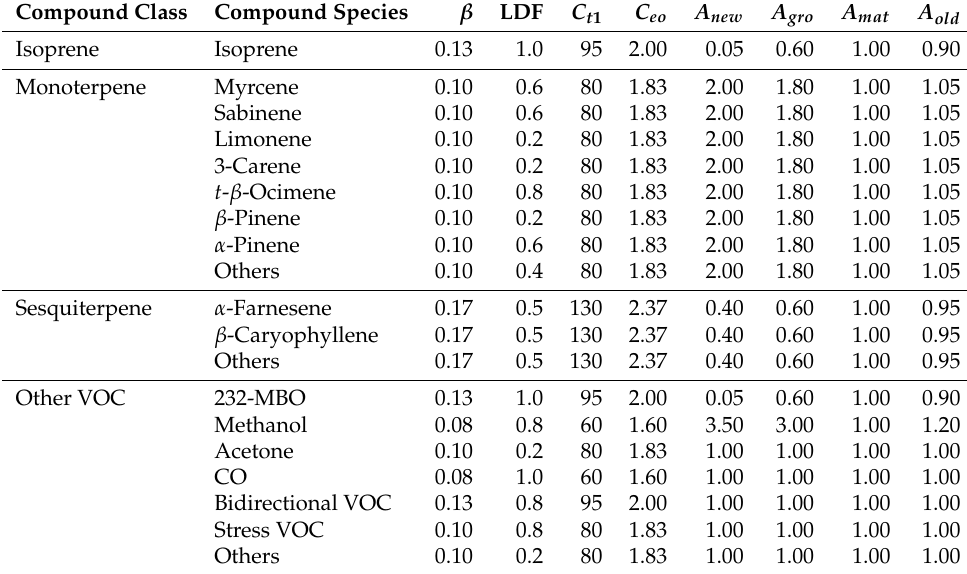
Table 2. Parameters for MEGAN model (adapted from Table 4 in Guenther et al.